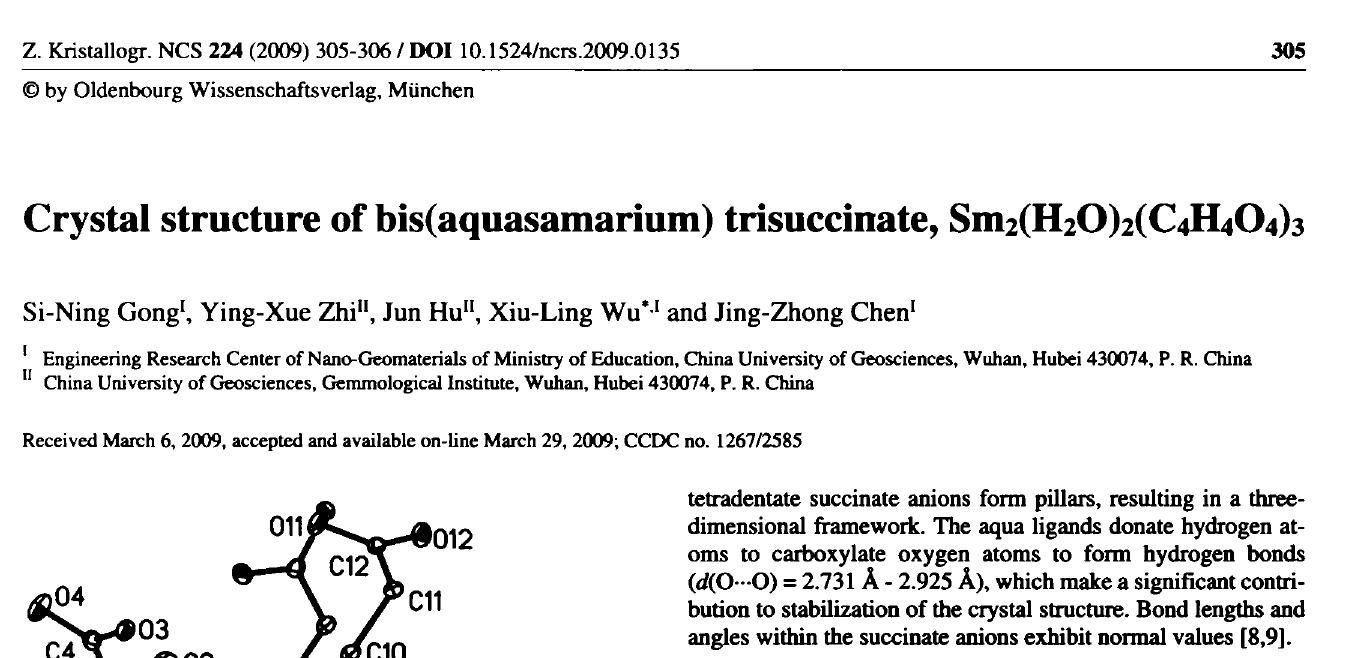
Table 2. Atomic coordinates and displacement parameters (in Â 2